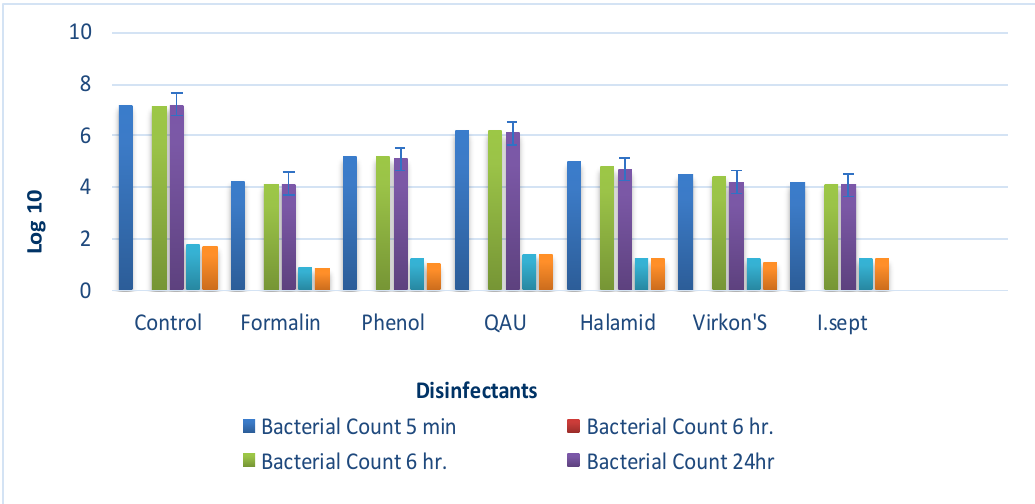
Fig. 2: The effect of high application level and contact time on total aerobic bacteria, yeast, and